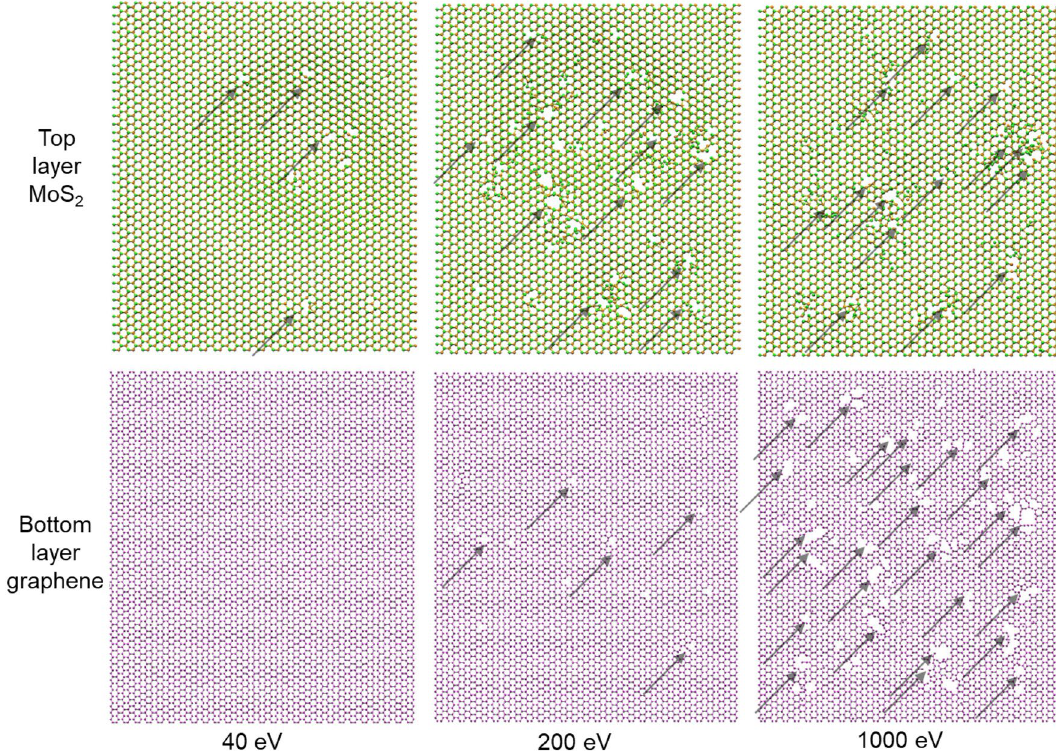
Figure 3. Morphologies of the suspended MoS 2 /graphene heterostructure layers under ion irradiation with different irradiation energies. The irradiation dose is 6.6 × 10 13 /cm 2